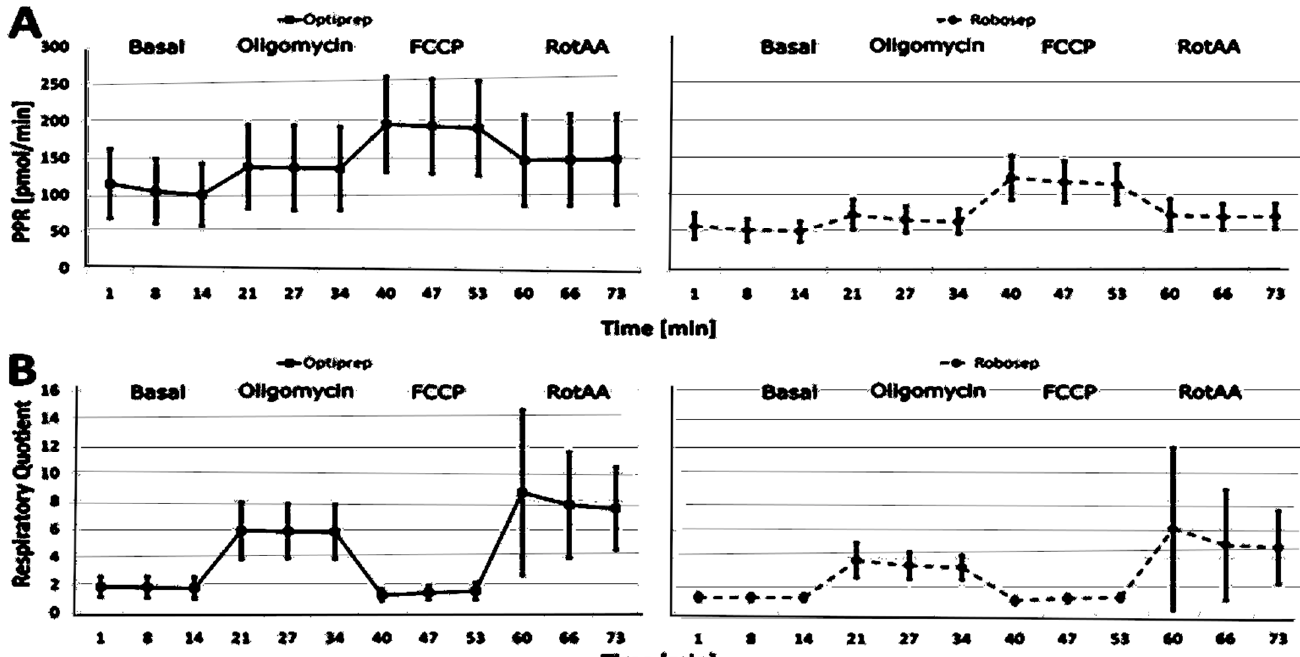
Figure 2. Cellular stress assay (CSA) with OptiPrep-isolated PBMCs ( n = 293) and Robosep-isolated PBMCs ( n = 185). ( A ) Proton production rate (PPR) and ( B ) respiratory quotient (RQ). The horizontal lines show the mean ± SD. It shows that the variation in proton production and extracellular acidification is much higher in Opti-isolated cells. FCCP = carbonyl cyanide 4-(trifluoromethoxy) phenylhydrazone; SD = standard division; RotAA = rotenone and antimycin A.